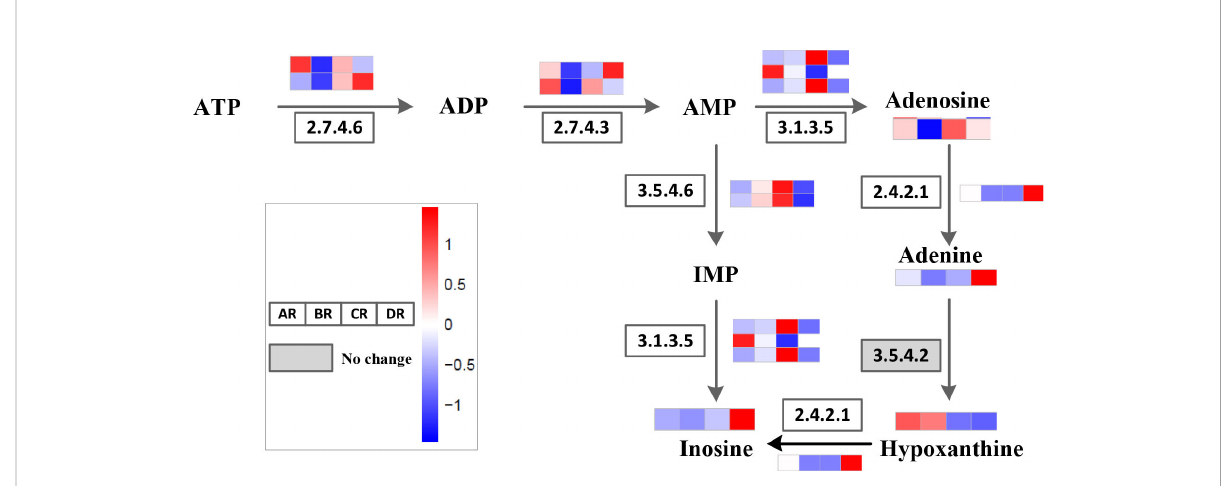
FIGURE 6 Changes of gene expression and metabolic level involved in the inosine